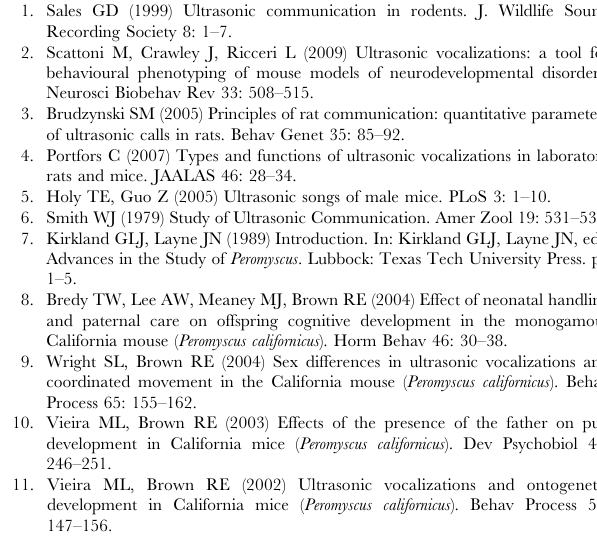
Table S2 Results from randomization tests of significant Mann- Whitney U variables between laboratory- and wild-recorded 1SVs, 2SVs, and